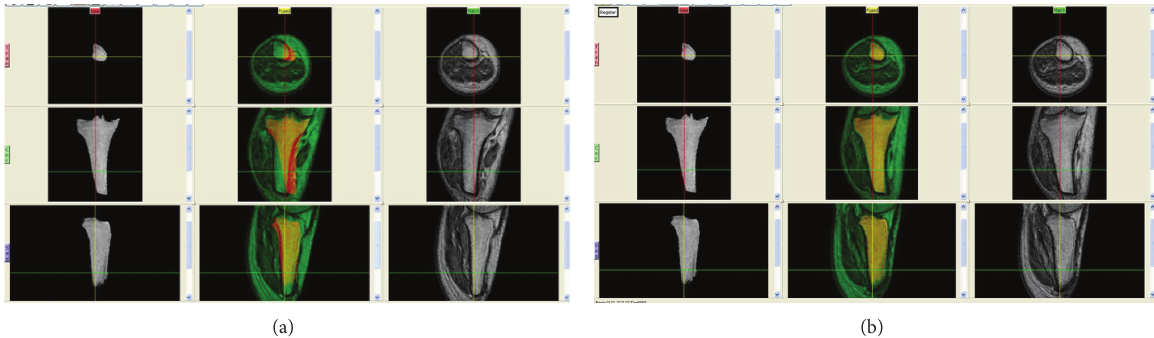
Figure 2: Volume registration in relation to the aligned tibia bone. (a) Before registration; (b) after registration.